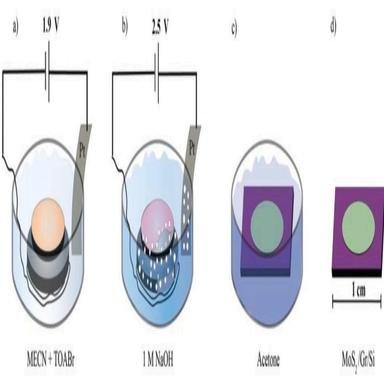
Scheme of the transfer process. a) The Ir crystal with grown MoS2/graphene HS is immersed into a solution of MeCN and tetra-n-octylammonium bromide. The crystal is connected with a Ni wire to the negative potential and a platinum foil is immersed into the same solution and connected to the positive potential, with a potential difference up to 1.9 V. b) The Ir crystal with the HS and an additionally deposited layer of PMMA is immersed into 1M NaOH solution and connected to the negative potential via the Ni w